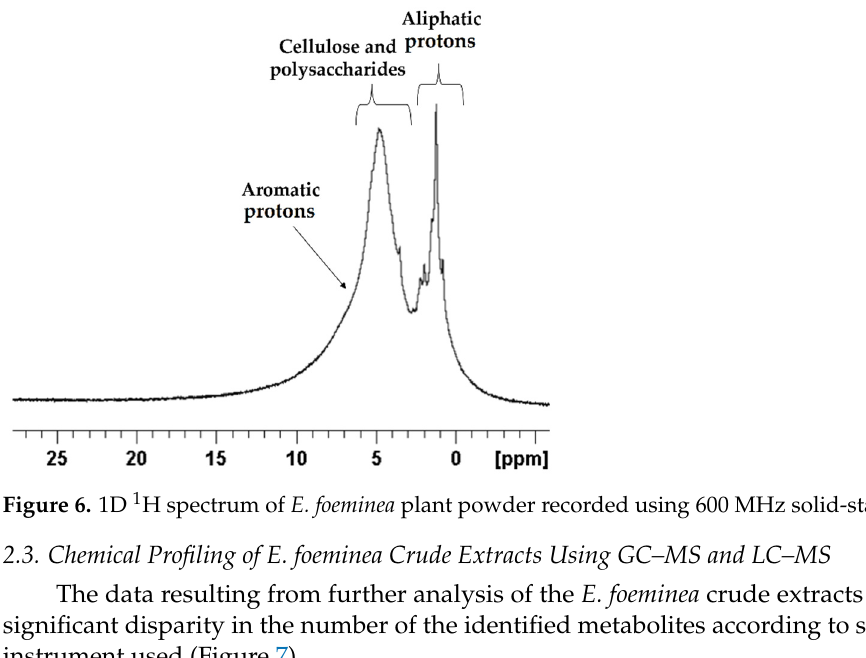
Figure 6. 1D 1 H spectrum of E. foeminea plant powder recorded using 600 MHz solid-state NMR. The spectrum obtained verified the 13 C results, where the δ 10 to 3 ppm mid-field sug- ars and polysaccharides region peaks are dominating the spectrum, while the aromatics re- gion is shown as a small shoulder around δ 7.5 ppm. On the other hand, the aliphatic reso- nance peaks were found to be pronounced as shown in the high-field region of δ 3 ppm.